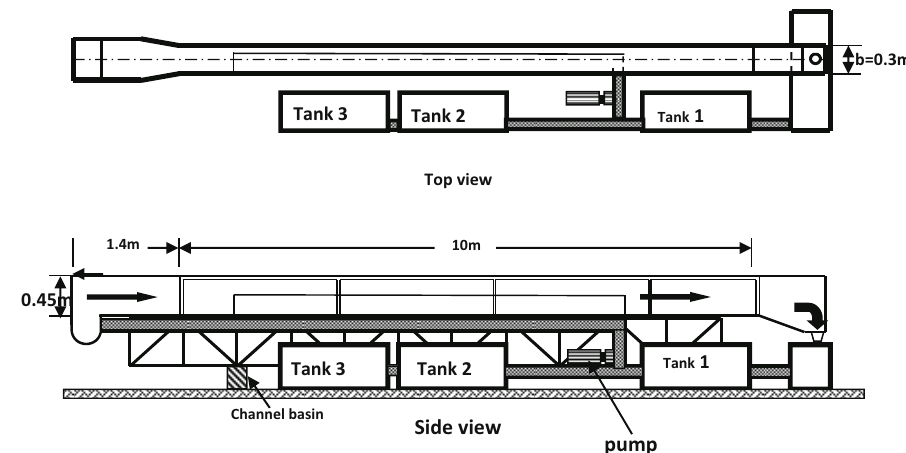
Figure 1: Laboratory fl ume